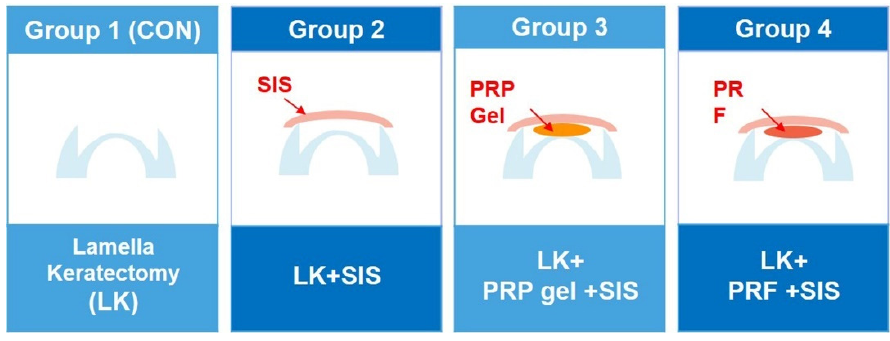
Figure 1. Schematic of the study. Group 1 had lamellar keratectomy only. SIS membrane grafting was used in group 2–4. PRP gel and PRF were applied in group 3 and group 4, respectively.